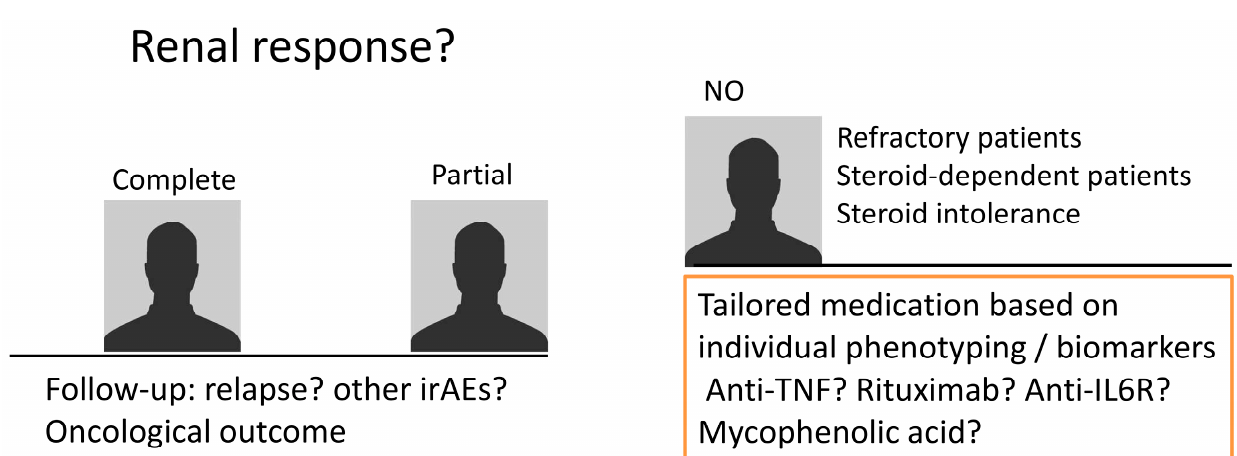
Figure 3. Therapeutic management for ICI-related renal toxicities When a patient is diagnosed with ICI-related ATIN, the therapeutic strategy is based on the discontinuation of ICI and co-medications. Corticosteroids are then the standard of care. Depending on the renal response, tailored medications based on individual phenotyping should be discussed. ATIN: acute tubulointerstitial nephritis; PPI: proton pump inhibitors; irAES immune related adverse events. PCP: pneumocystosis.